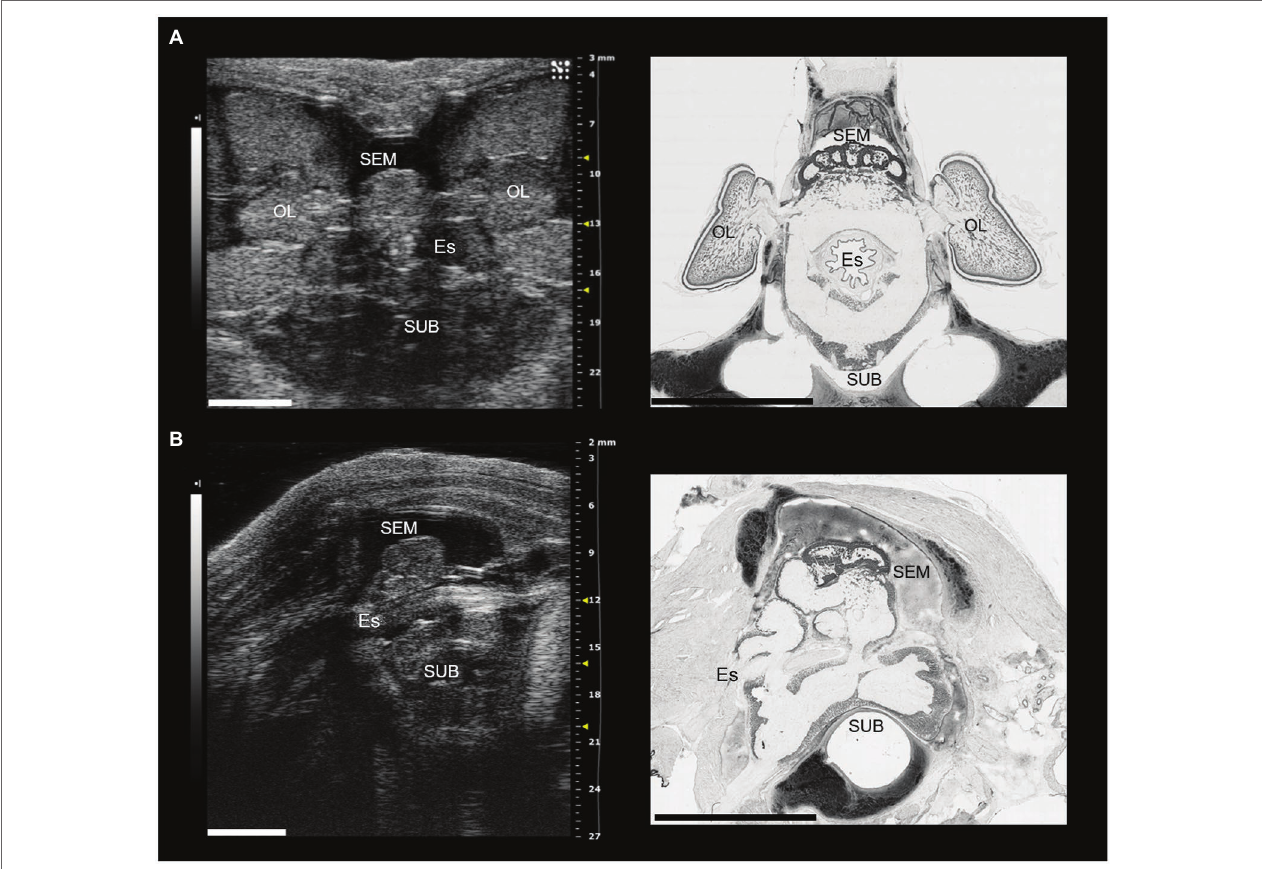
FIGURE 1 | The brain of Octopus vulgaris as it appears using sonographic scanning (for additional details see Grimaldi et al., 2007) and histological sections after Nissl staining (in black and white). (A) Ultrasound examination (left) of the entire cerebral mass in the coronal plane, and the corresponding histological section (right) . The optic lobes are visible bilaterally and appear connected through the optic tracts to the central brain (supraesophageal mass, SEM). The subesophageal mass (SUB) lies ventrolateral to the esophagus (Es). (B) Ultrasound examination of the central brain in the sagittal plane (left) , and the equivalent histological section (right) . The two masses (SEM and SUB: dorsally and ventrally, respectively) are clearly visible with the esophagus in the middle. OL, optic lobe; Es, esophagus; SEM, supraesophageal mass; SUB, subesophageal mass. Scale bars: 5